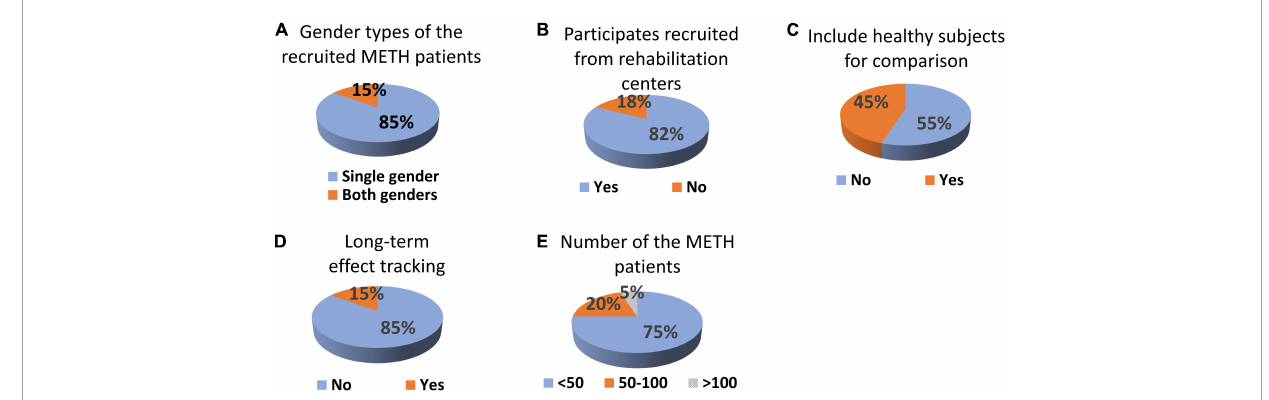
FIGURE5 The summary of the limitations of literatures listed in Tables 1 – 4 . (A) Gender types of the recruited subjects with METH addiction; (B) whether the participants are recruited from rehabilitation centers; (C) whether healthy subjects are included as comparison; (D) whether long-term effects are tracked; and (E) number of the subject with METH addiction in each